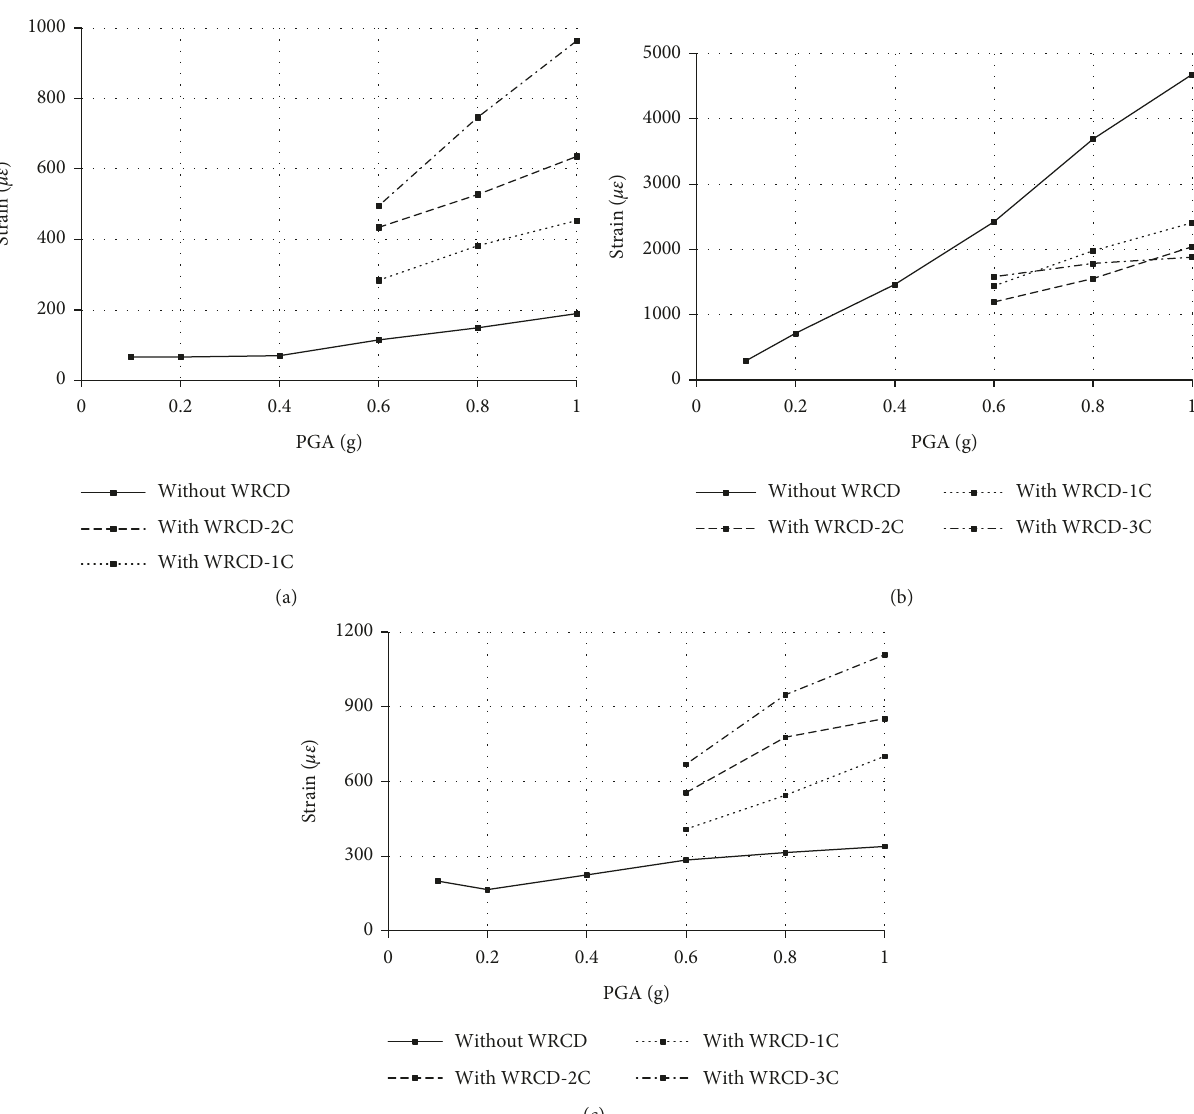
Figure 12: Strain variation trend with seismic input intensity under Tianjin ground motion. (a) Bottom of movable pier #1. (b) Fixed bottom of pier #2. (c) Bottom of movable pier